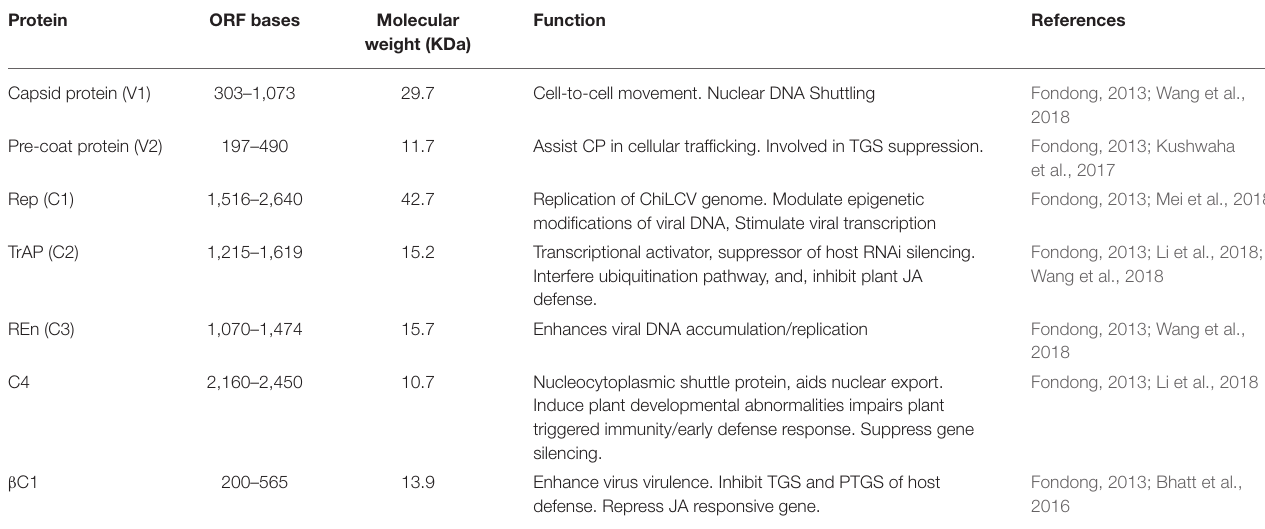
TABLE 2 | The genome of chili leaf curl virus consisting of various open reading frames codes for different proteins having different functions in virus accumulation, movement, replication and post transcriptional gene silencing.